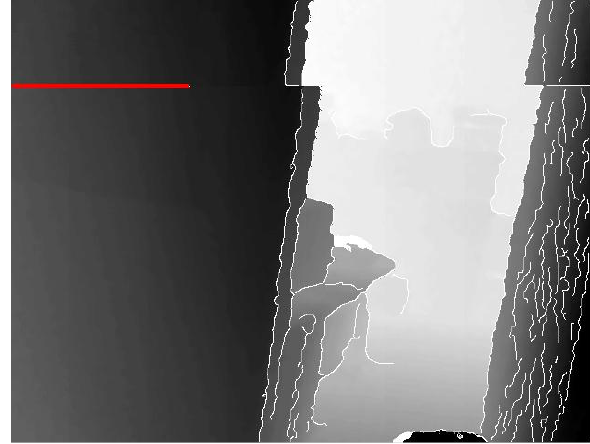
Figure 12. Edges extracted using Canny and horizontal line (highlighted red line) is recognized using Hough transform.